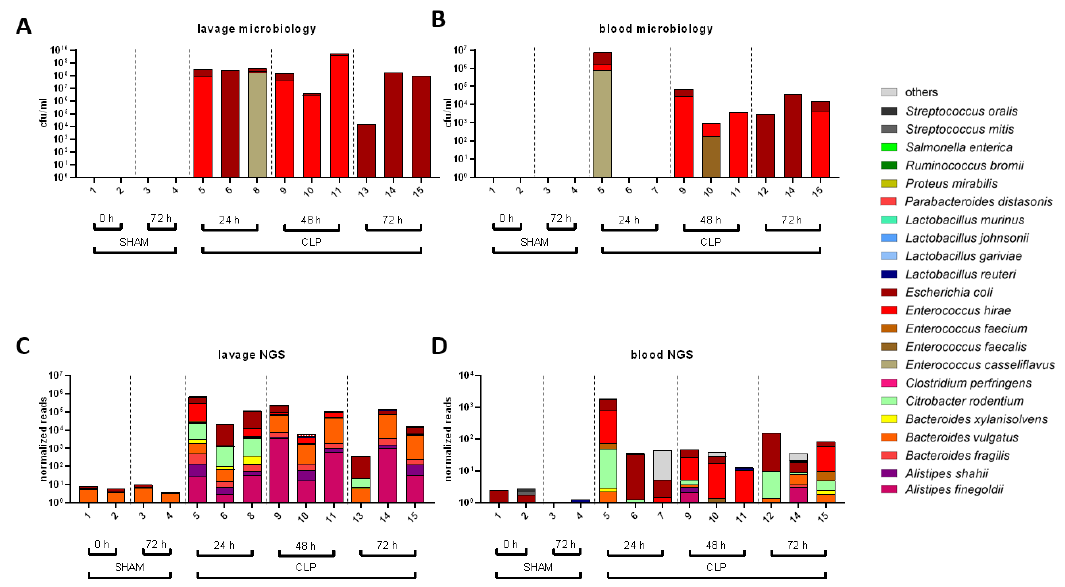
Figure 3. Transition of microbes into peritoneum and blood as revealed by NGS and microbiology. ( A – D ): The most frequent bacterial species found in the lavage ( A , C ) and blood ( B , D ) detected by the culture-based methods ( A , B ) and by whole genome shotgun sequencing ( C , D ).